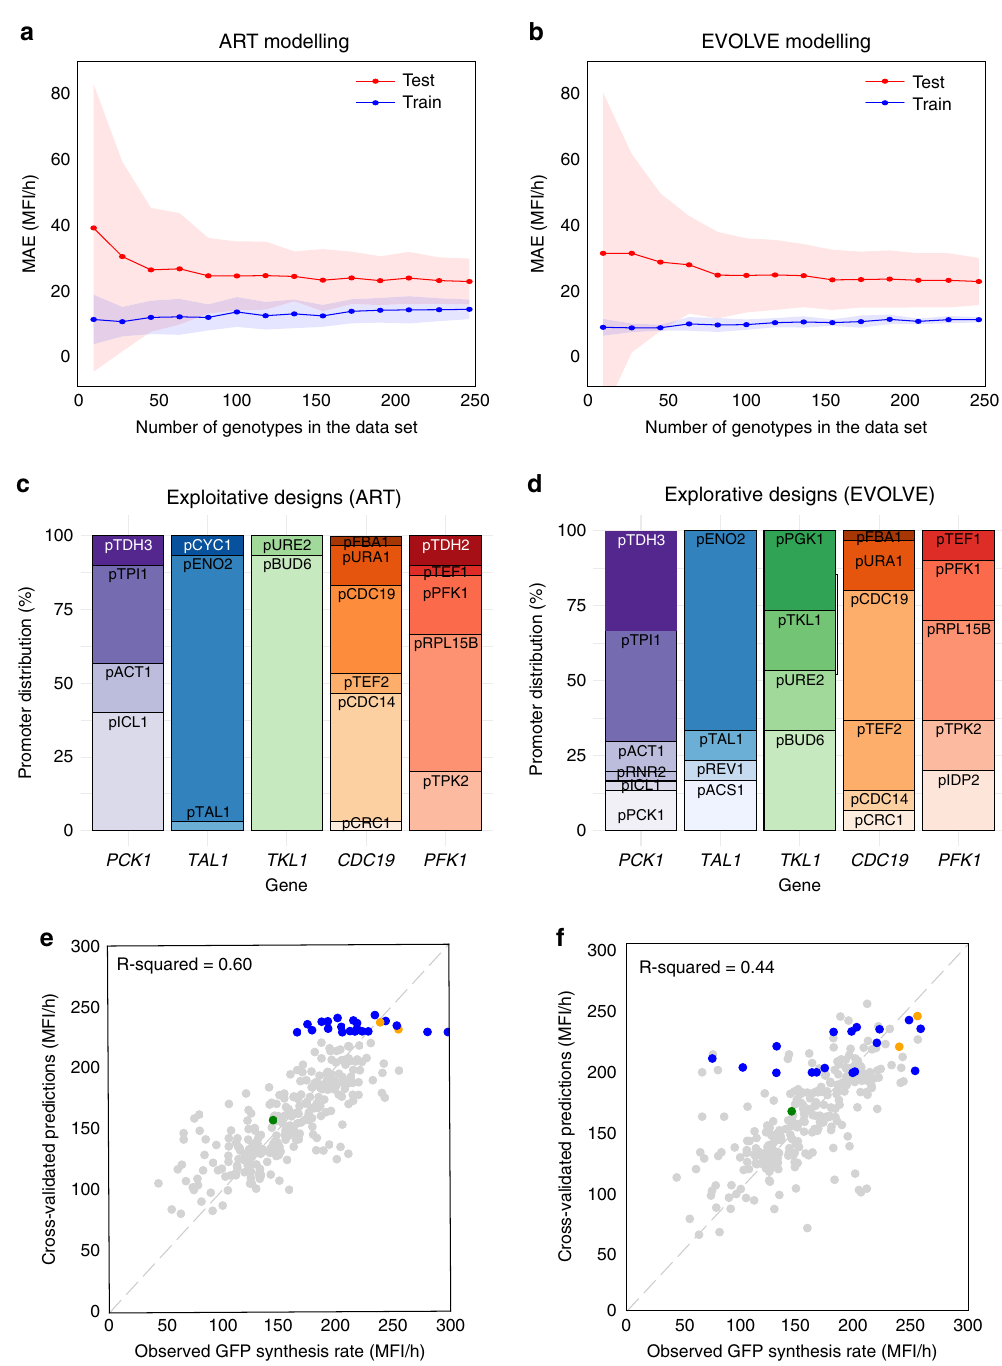
Fig. 4 Machine learning-guided predictive engineering of tryptophan metabolism. a , b Learning curves for ART and EVOLVE algorithms, respectively. Mean absolute error (MAE) from model training and testing as a function of the number of genotypes in the dataset. Shaded areas represent 95% con fi dence intervals based on ten random samples of the given no of genotypes ( n ). Blue curves indicate MAE when calculated for the whole dataset (train), while red curves indicate the cross-validation, i.e., by training the models on 80% of the data and then testing the predictions of this model against measurements for the remaining 20% (test). c , d Promoter distributions for the 30 recommendations of the exploitative (ART) and explorative (EVOLVE) approach, respectively. The orders and colors of promoters correspond to those in Fig. 1c. e , f Cross-validated predictions vs average of measured GFP synthesis rate for the exploitative (ART) and explorative (EVOLVE) approach, respectively. Data are shown for library and control strains (gray markers; green markers show the platform strain expressing ARO4 K229L and TRP2 S65R,S76L ), as well as for recommended strains (blue markers; orange markers show recommendations that overlap between the two approaches). R -squared values are for cross-validated predictions for the whole dataset (not only training set data). MFI mean fl uorescence intensity. Source data are provided as a Source data fi